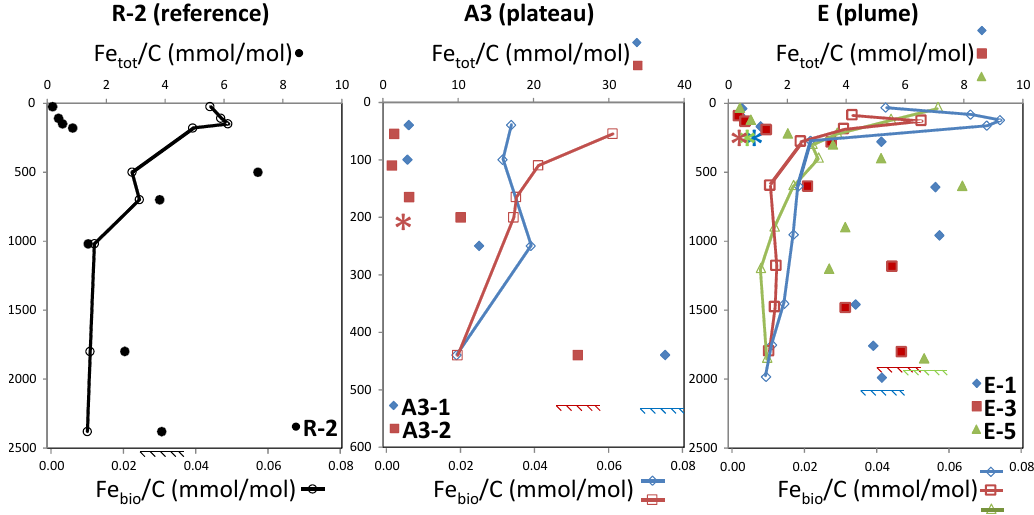
Figure 5. Vertical profiles of Fe / C ratios in suspended (ISP) and sinking (P-trap) particles. Solid symbols indicate total Fe / C (i.e. ratio of biogenic + lithogenic Fe over POC) and joined open symbols indicate Fe bio / C (i.e. ratio of biogenic Fe only over POC; calculated using P as a normaliser). The asterisk markers ( ∗ ) show the export total Fe / C ratio (P-traps). Note the different scale on the x axis for Fe / C at A3